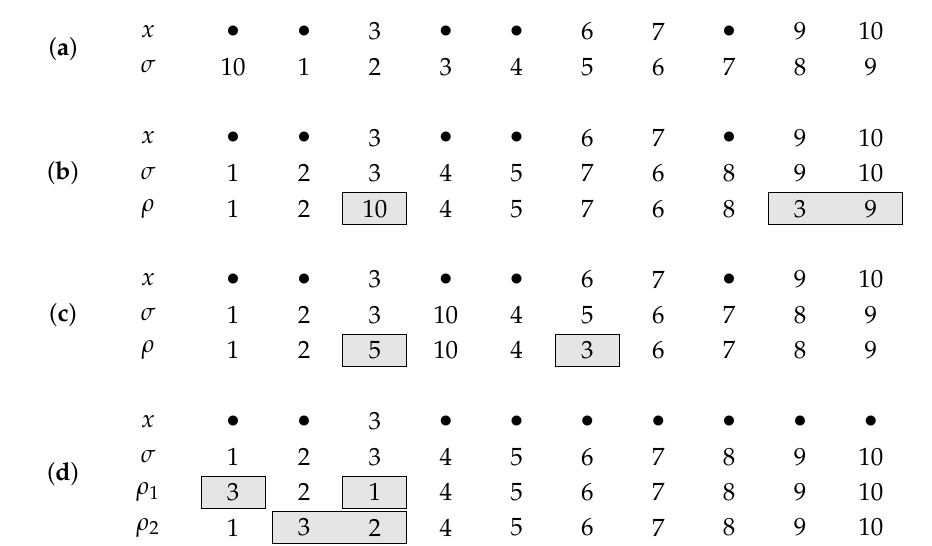
Figure 1. Illustrating the cases considered by infoP. Panel ( a ): query σ does not coincide with the partial solution x ; infoP ( σ , x , y ) = info ( σ , y ) . Panel ( b ): σ and x coincide in more than one position; ρ rearranges these positions of σ ; infoP ( σ , x , y ) = info ( ρ , y ) . Panel ( c ): σ and x coincide in exactly one position i , but more positions are identified already; ρ is obtained from σ by swapping position i with another identified position j ; infoP ( σ , x , y ) = info ( ρ , y ) . Panel ( d ): Exactly one position is identified and appears to be correct in σ ; two modified queries ρ 1 and ρ 2 must be defined, each by swapping the identified position with another one; infoP ( σ , x , y ) = no if and only if info ( ρ 1 , y ) = info ( ρ 2 , y ) =